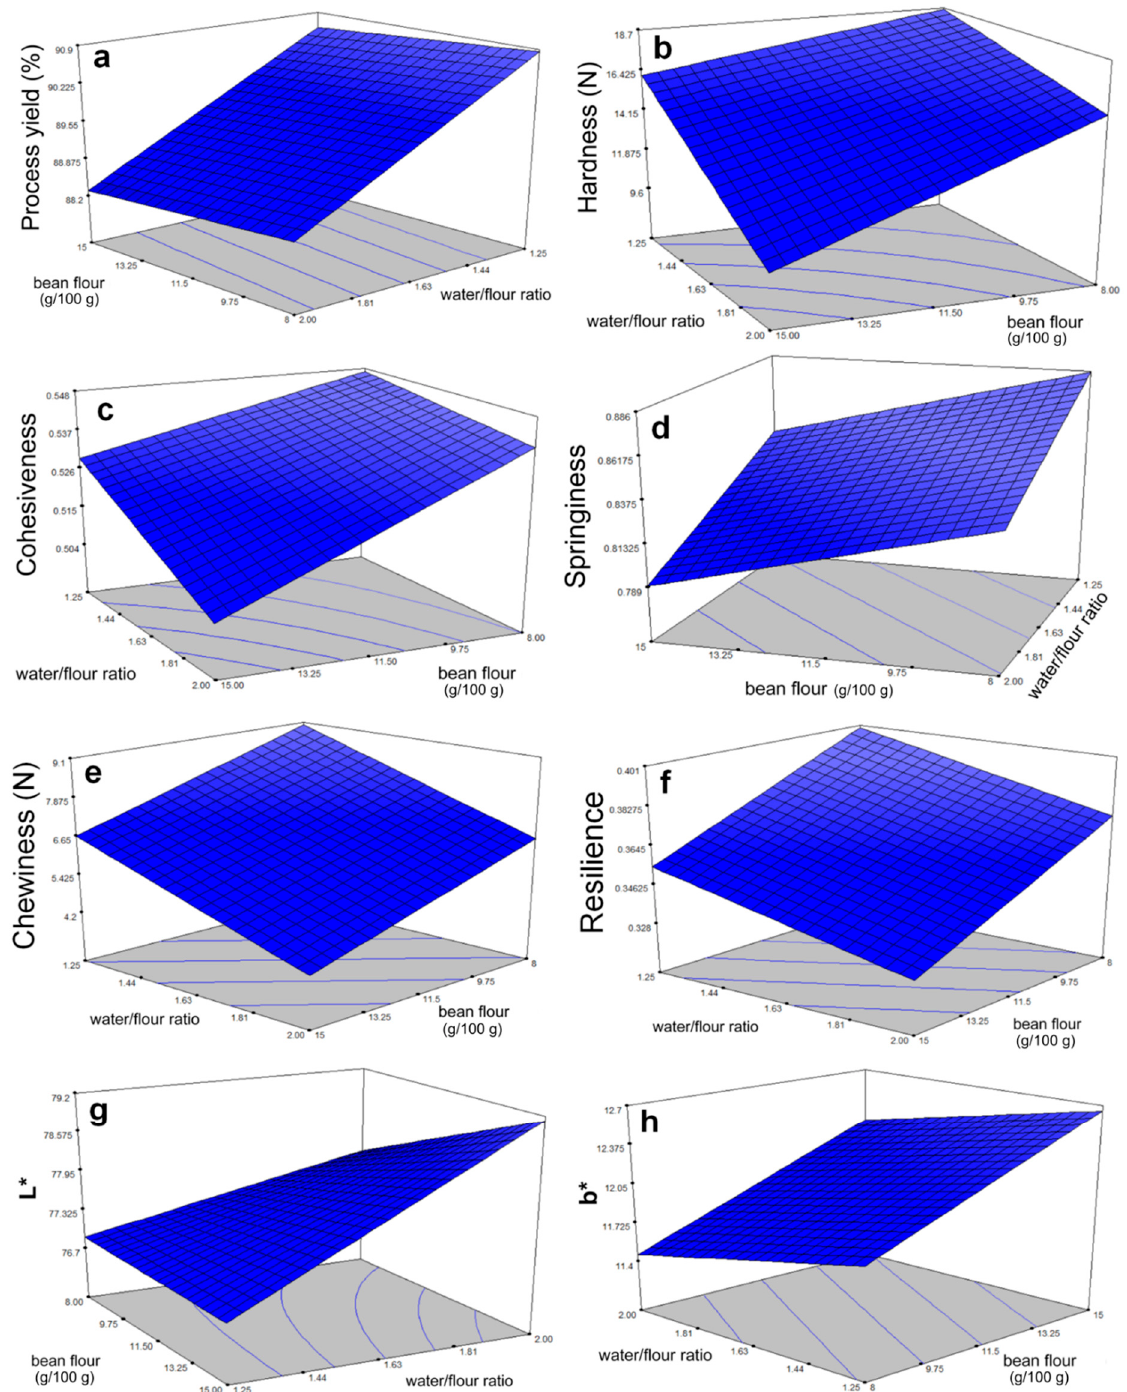
Figure 1. Contour plots of the variation of ( a ) process yield (g/100 g); ( b ) hardness (N); ( c ) cohesiveness; ( d ) springiness; ( e ) chewiness (N); ( f ) resilience; ( g ) lightness (L*); ( h ) yellowness (b*), as a function of bean flour (BF) level (g/100 g) and water/bean flour ratio (W/BF) of BF-burgers. Darker colors indicate lower values of the modeled responses.